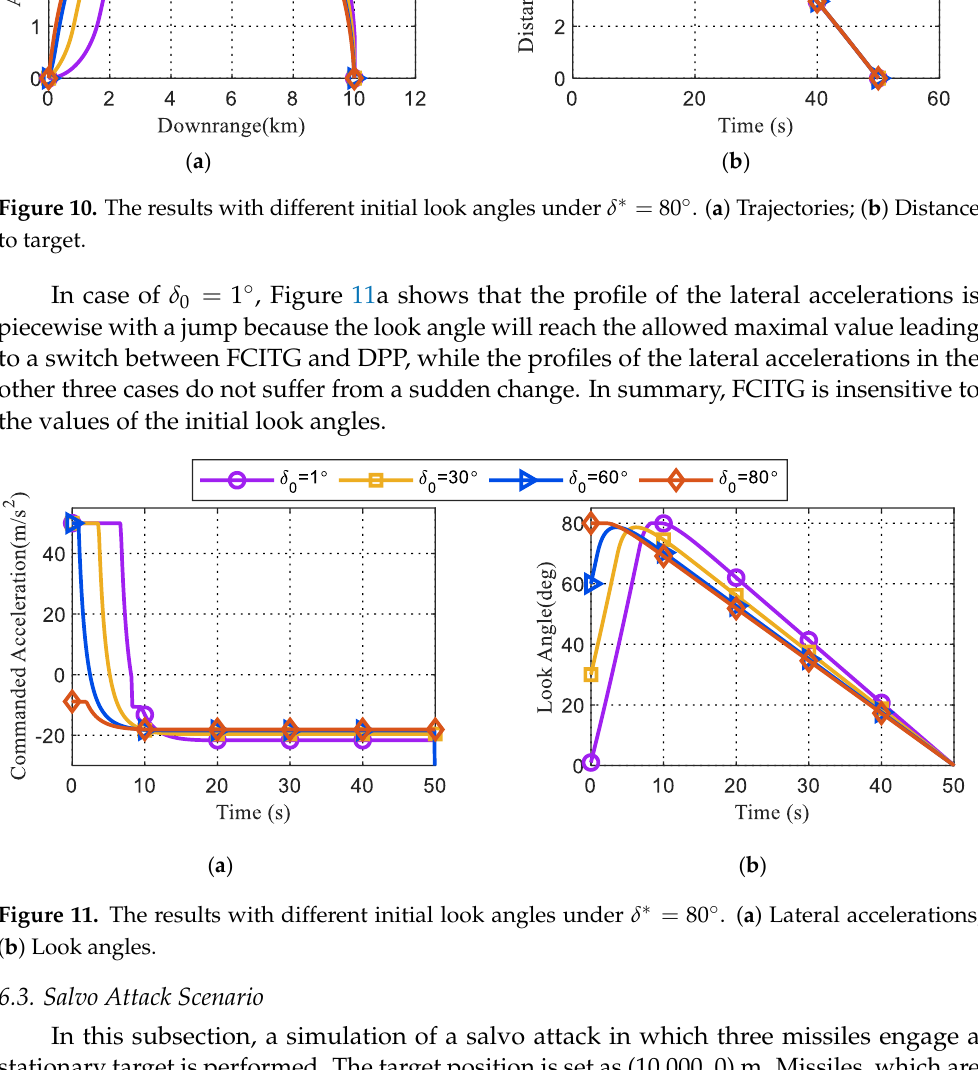
( b ) Look Look angles.